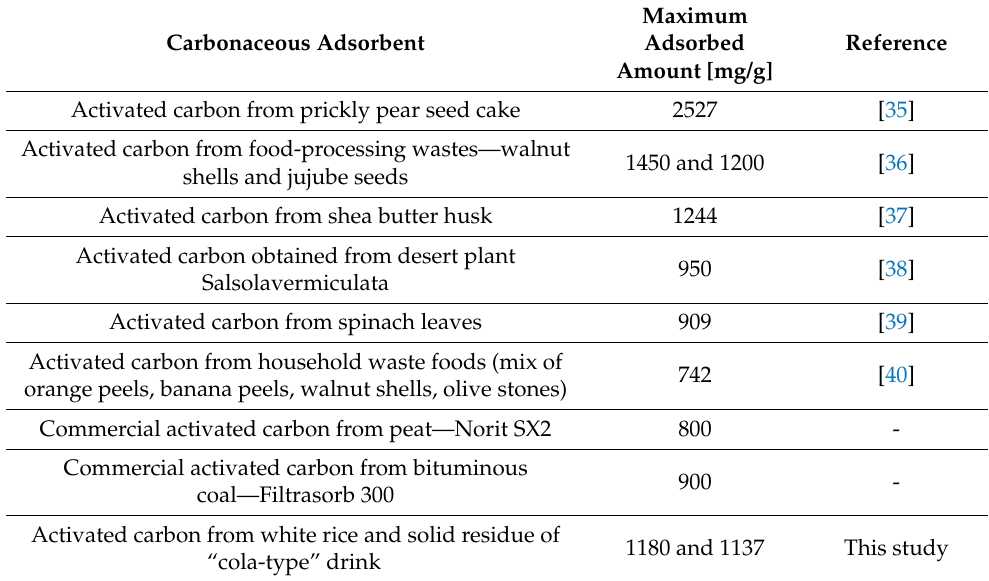
Table 4. Adsorption capacities toward iodine for various carbonaceous